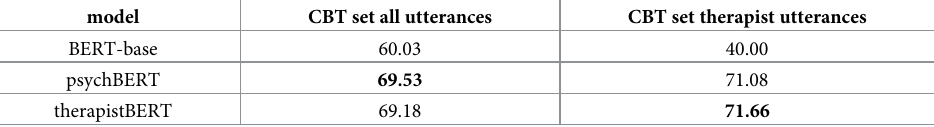
Table 4. Accuracy (%) for the next sentence prediction task before and after BERT adaptation when the models are evaluated on the CBT